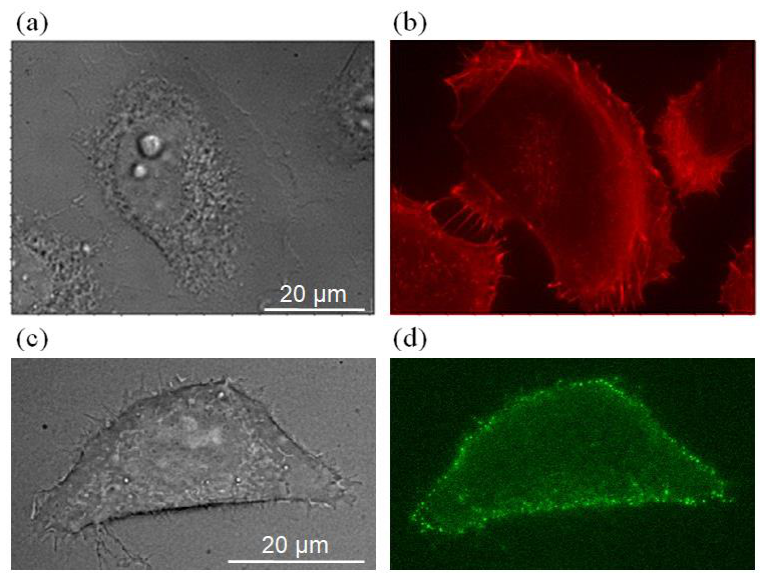
Figure 3. Comparison of the bright-field image of HT29 cell ( a , c ), the fluorescence image of the distribution of actin filament ( b ), and the simultaneous QD – EGF fluorescence image ( d ).